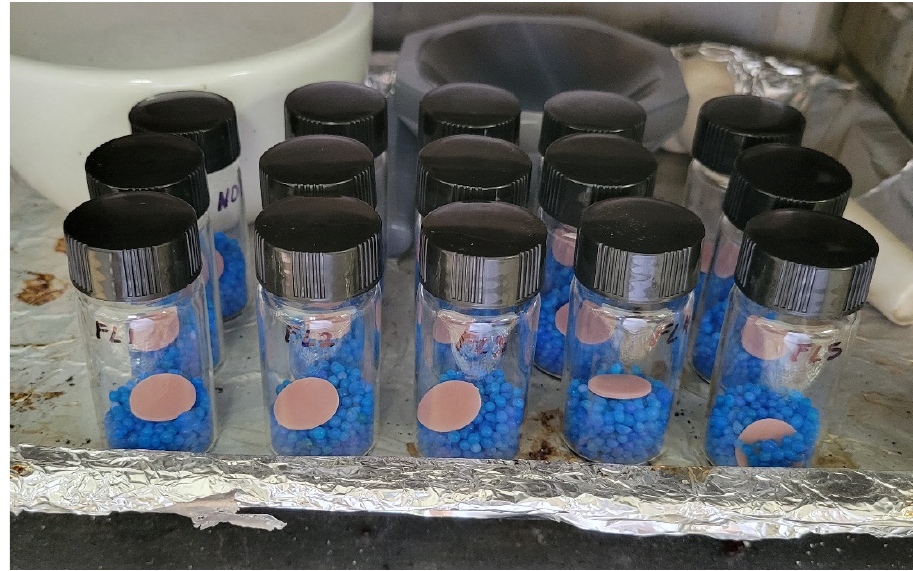
Figure 4. Specimens dehydrating in desiccators in an oven at 37